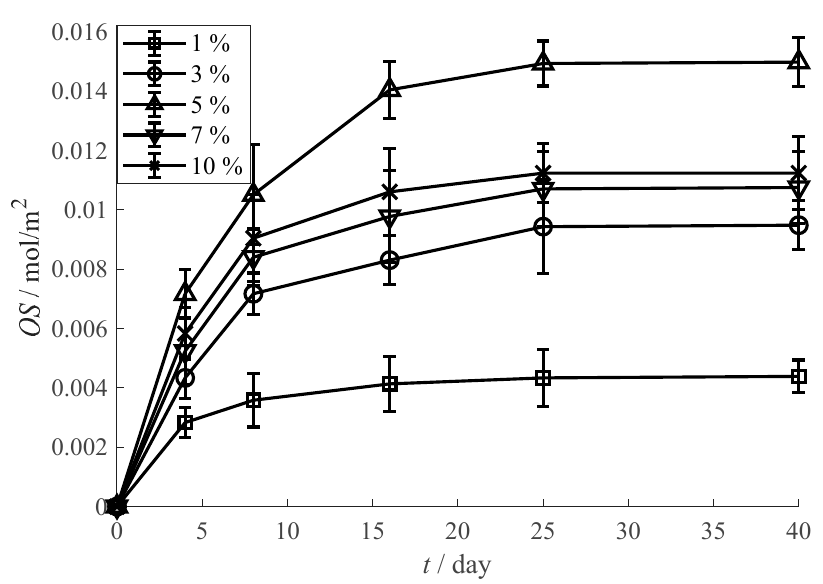
Figure 5. Influence of oxygen scavenger content on the oxygen scavenging performance.